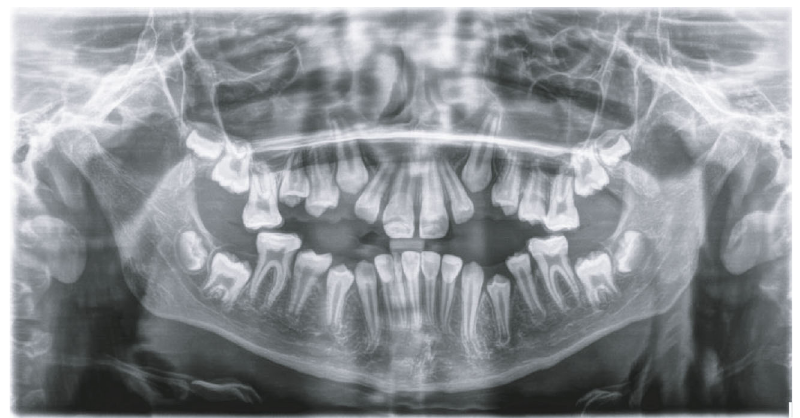
Figure 17: Postoperative panoramic radiographic view.